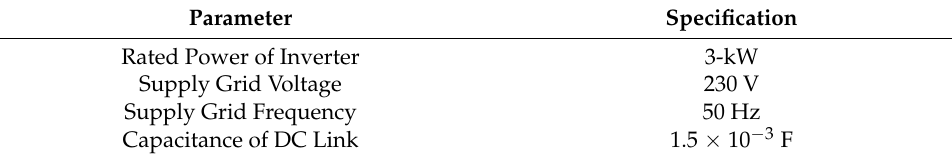
Figure 6. Proposed single phase 3 kW grid connected PV system.